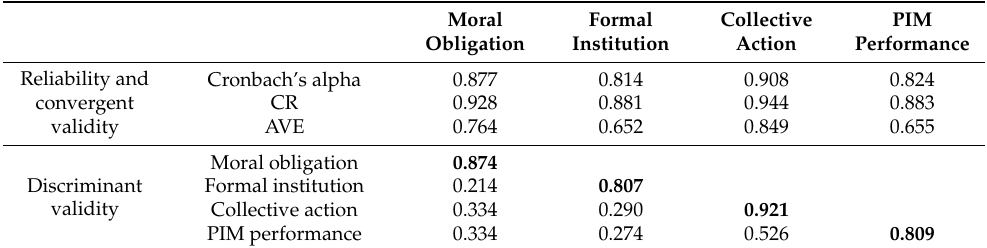
Table 2. The outcome of reliability and validity